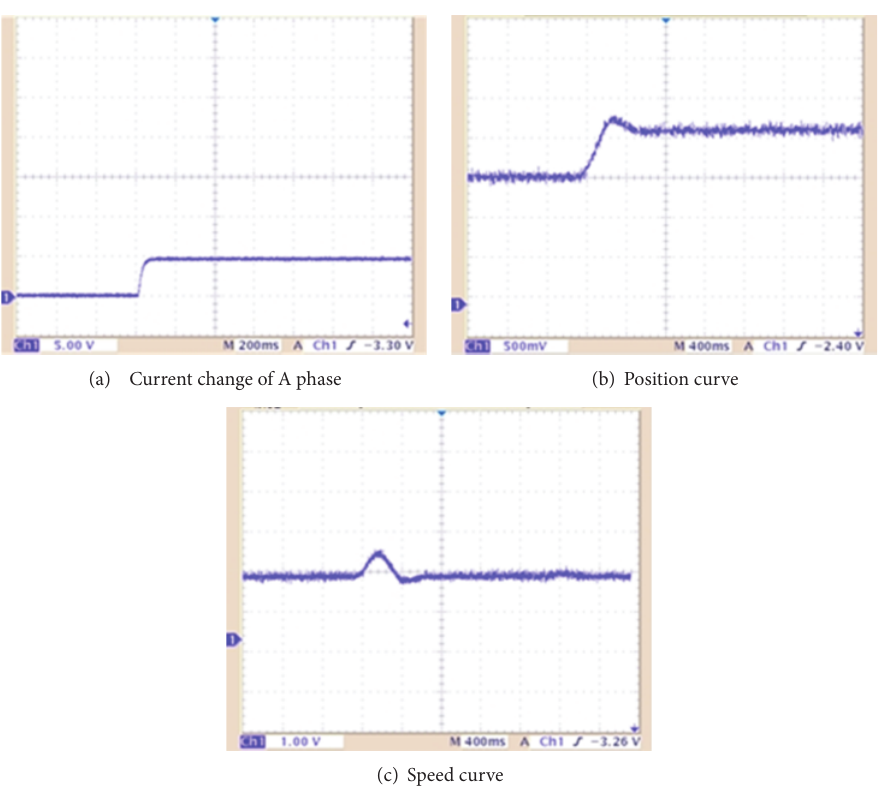
Figure 14: Experiment curve of pointing